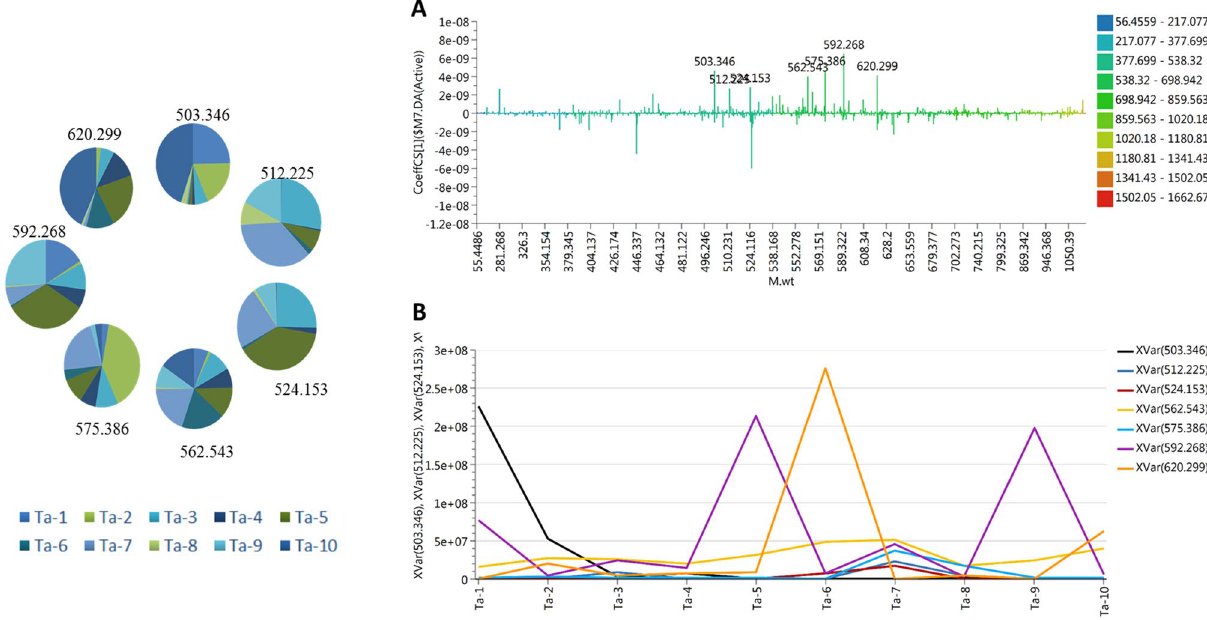
Figure 4. ( A ) Coefficient of variation of metabolites linked to CACO2 cytotoxicity; ( B ) intensity of the top correlated metabolites across the tested species (Cytoscape software, version